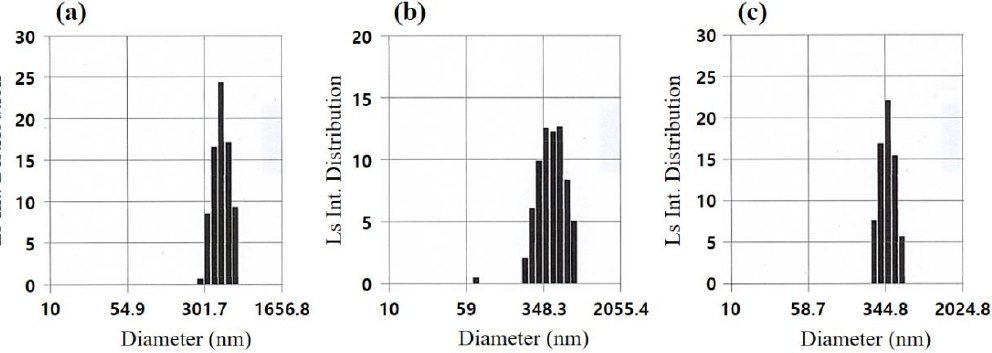
Figure 13. Particle size distribution of KNN particles synthesized in glycothermal conditions with various molar ratios of K + /Na + at 200 °C for 12 h: ( a ) 1.4/0.6, ( b ) 1.6/0.4, and ( c ) 1.8/0.2.